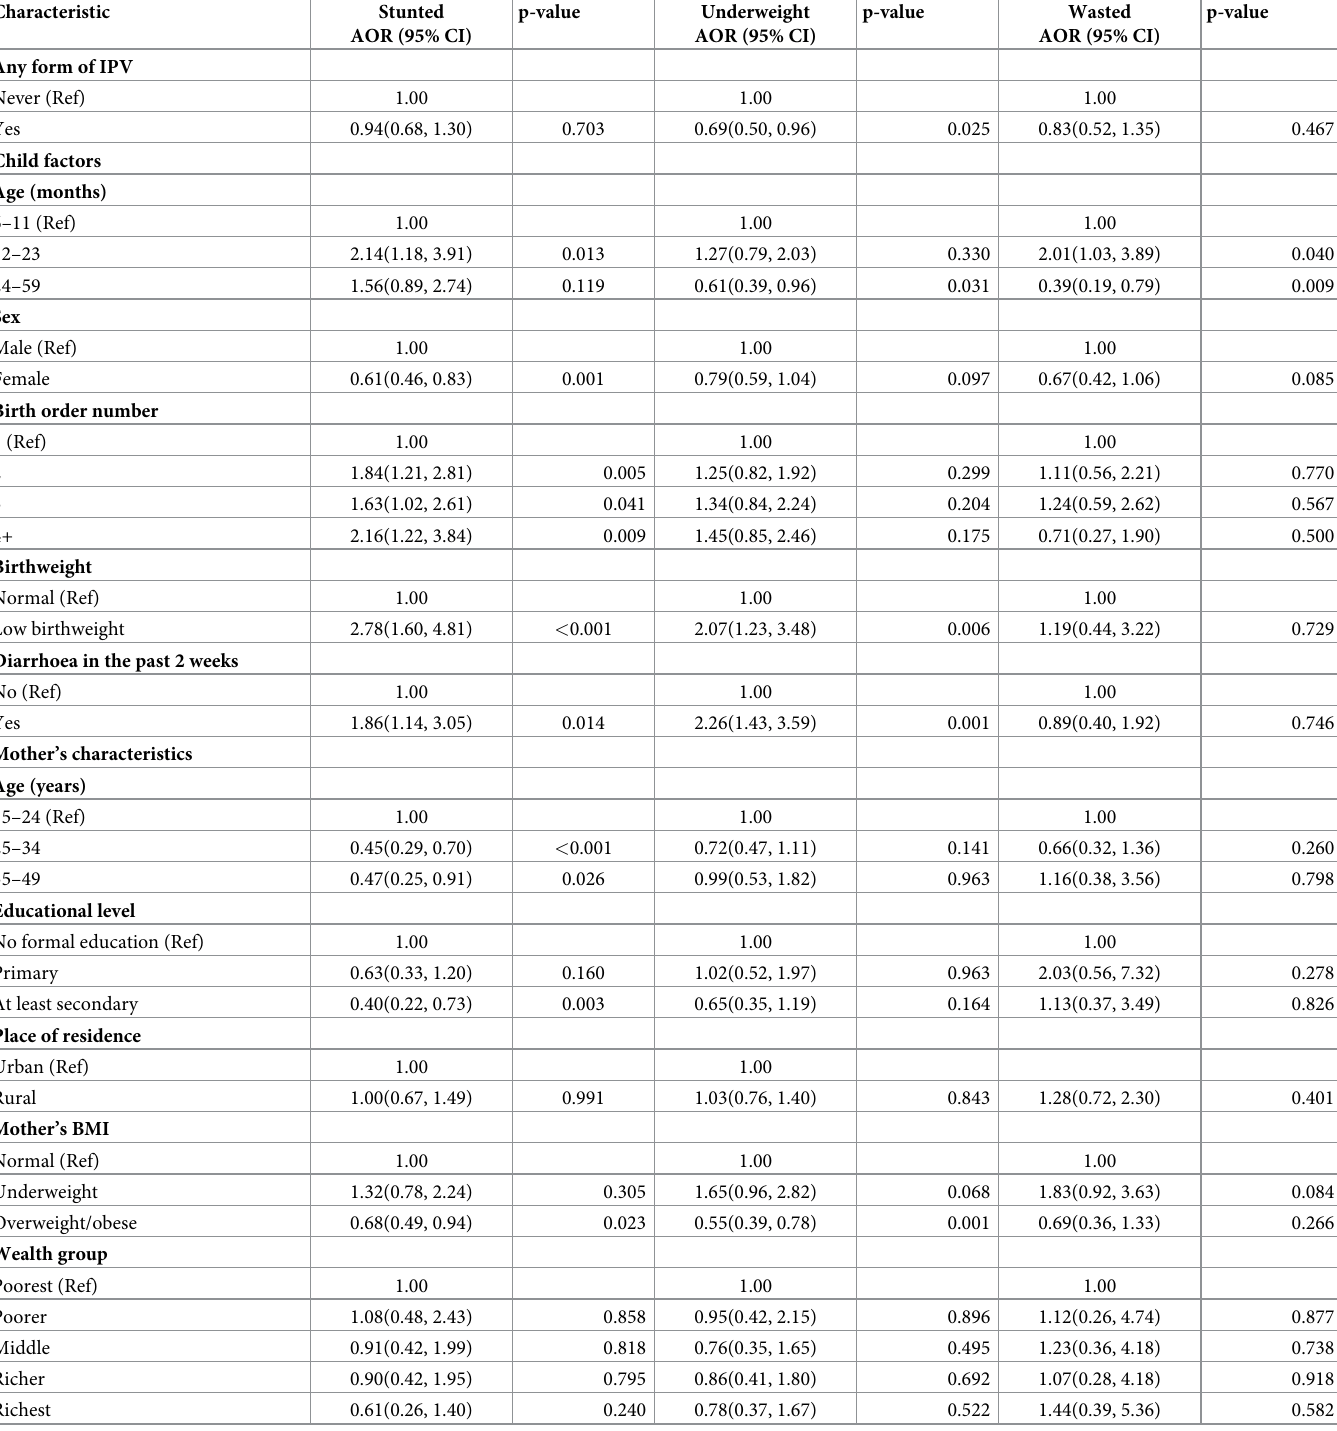
Table 4. Association between women’s experience with intimate partner violence and their children’s nutritional status (weighted N = 2,142).